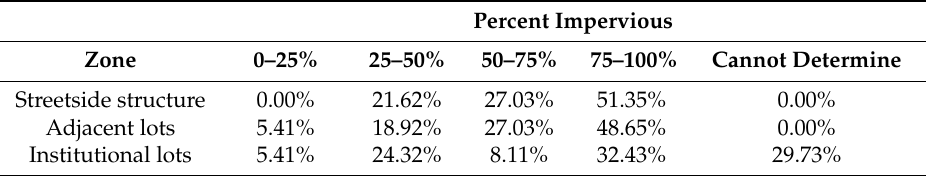
Table 2. Percent impervious surface surrounding high-priority GSI implementation sites.